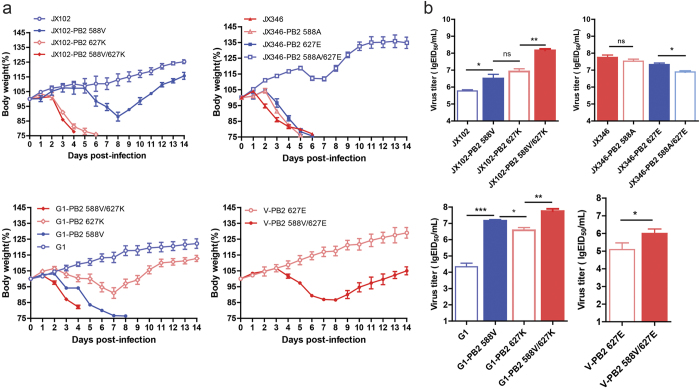
Infection and replication of H10N8, H7N9 and H9N2 viruses bearing different PB2 genotypes in mice.(a) Body weight changes post infection. Group of BALB/c mice (n = 11) were intranasally inoculated with 105 EID50 (50 μl) of each virus as indicated. Body weight was monitored for 14 days and shown as means ± SD of 8 infected mice. (b) Virus replication in mouse lungs. Three mice from each group were euthanized at 3 days post infection and lung virus titers were determined. The values represent the log10 mean titers ± SD. Statistical significance was calculated using an unpaired t test: **P < 0.01; *P < 0.05; ns, no significance.